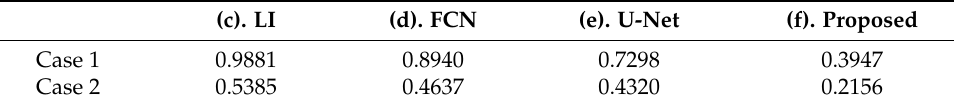
Figure 10. Results of head phantom, where the first row is the sinogram, the second row is the FBP reconstruction results, and the third row is an enlarged view of the ROIs. The display window of sinogram is (0, 1). The display window of CT and ROIs is ( − 0.01, 0.025). Table 3. MAE results of complement sinogram of actual